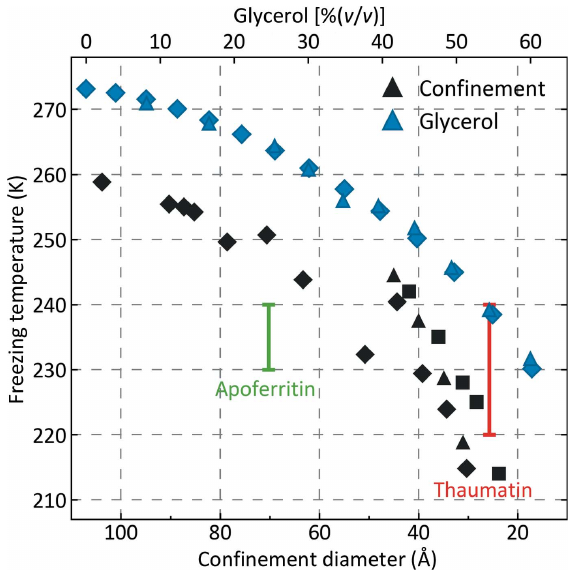
Figure 4 Blue points and upper scale: freezing temperature of bulk aqueous glycerol solutions versus glycerol concentration from Lane (1925) (triangles) and Segur (1946) (diamonds). Black points and lower scale: freezing temperature of pure water versus confinement diameter for confinement in cylindrical nanopores formed in silica from Findenegg et al. (2008) (triangles), Ja¨hnert et al. (2008) (squares) and Kittaka et al. (2006) (diamonds). Confinement within (cid:2) 100 A˚ pores is as effective as adding 30–35%( v / v ) glycerol in suppressing freezing